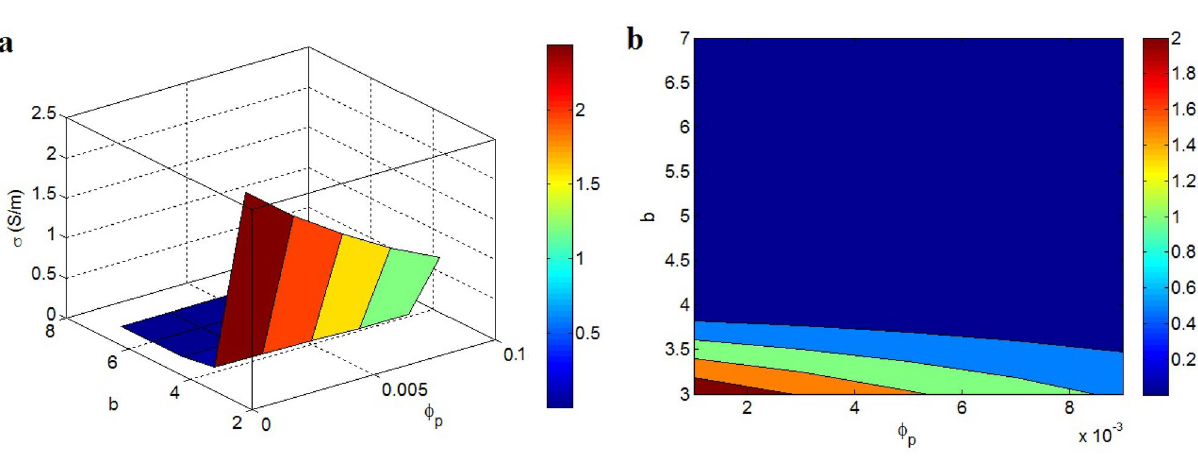
Figure 6. The stimuli of “ ϕ p ” and “b” on the conductivity: ( a ) 3D and ( b ) 2D